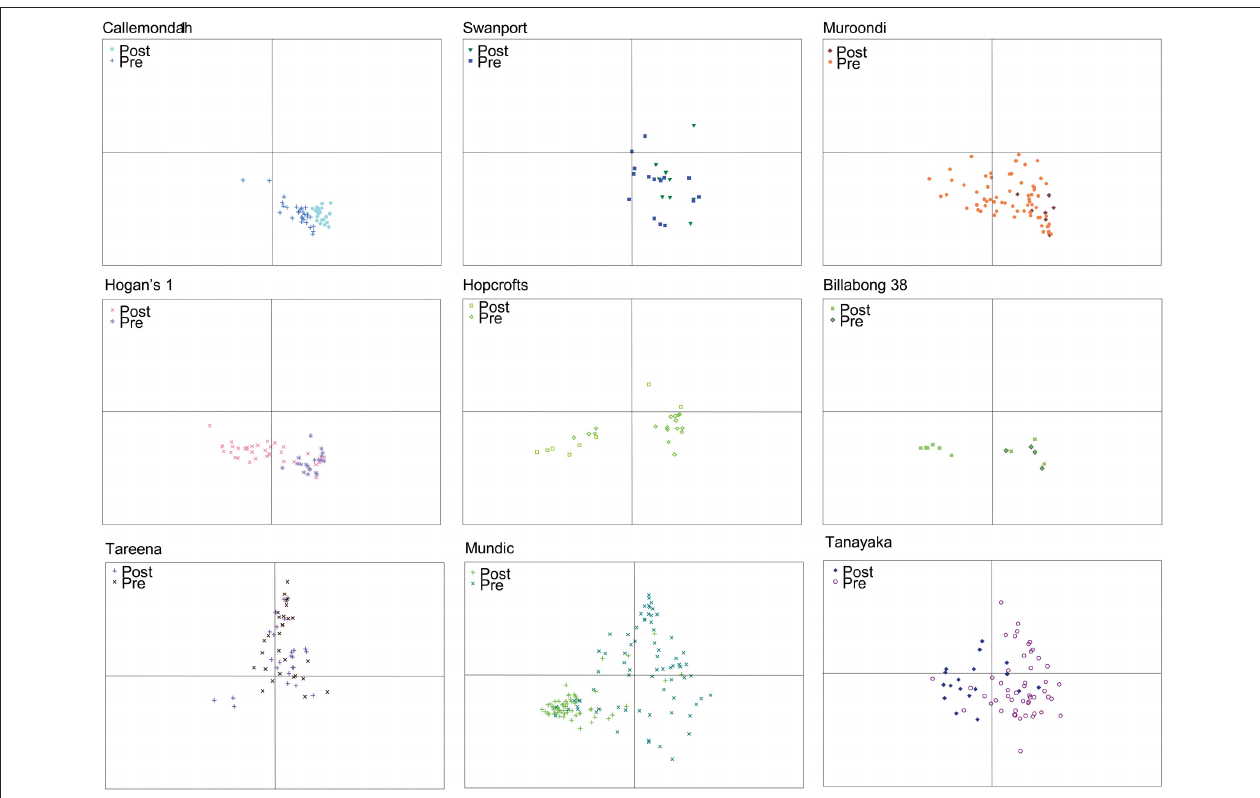
FIGURE 5 | nMDS ordination plots of axes 1 and 2 scores for diatom assemblages from specific billabong sediment records illustrating examples of “stable” (Callemondah 1, Swanport, Muroondi), “switching” (Hogans 1, Hopcrofts, Billabong 38), and “unstable” (Tareena, Tanyaka, Mundic) billabong response types. Samples in each plot are distinguished as being from the pre-European (Pre) and post-European (Post) settlement periods Note that each site plot is a subset of the data points shown in the nMDS ordination of all sites and samples shown in Figure 4